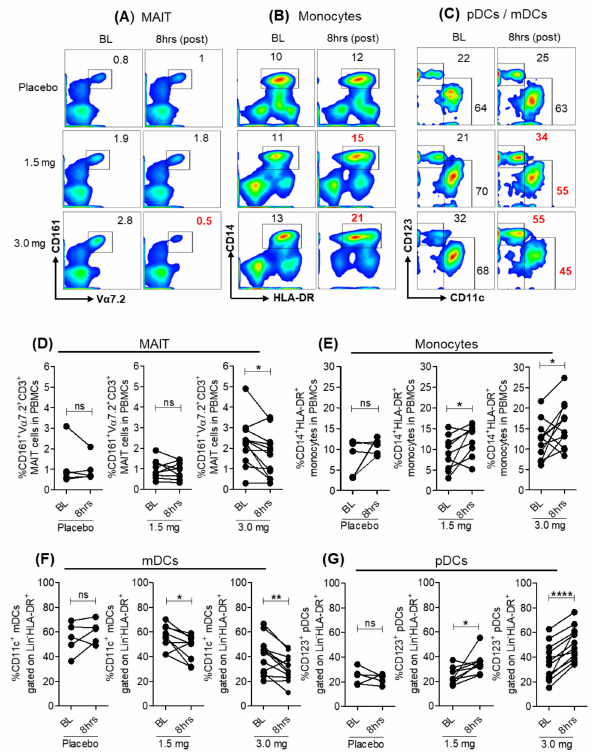
Figure 1. Frequencies of peripheral blood immune cells after Selgantolimod (SLGN) oral administra- tion in healthy subjects. Flow cytometric analysis of PBMCs from BL (Pre) and 8 h (post-treatment) from individuals administered placebo ( n = 5) or indicated dosage of SLGN (1.5 mg ( n = 9) and 3.0 mg ( n = 12)). Representative figures show gating for ( A ) MAIT (CD161 + V α 7.2 + ), ( B ) CD14 + HLA-DR + monocytes and ( C ) CD123 + pDCs and CD11c + mDCs. Comparative analyses of frequencies of immune cell subsets from baseline (BL) and 8 h samples in placebo or SLGN treated individuals (1.5 or 3.0 mg) for ( D ) MAIT, ( E ) monocytes, ( F ) mDCs and ( G ) pDCs are shown. Significance calcu- lated by a Wilcoxon matched-pairs signed-rank test. p values ≤ 0.05 *, 0.01 ** and 0.0001 **** show grades of significance. ns: no